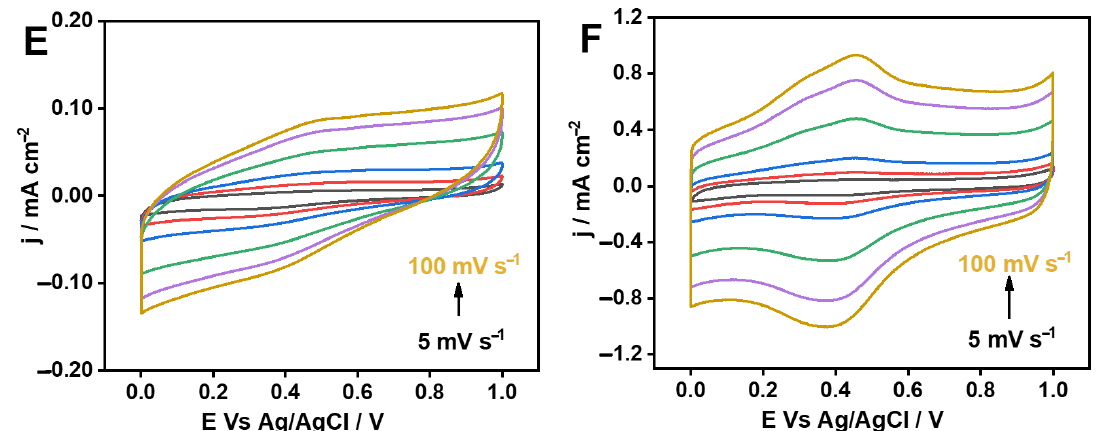
Figure 6. Scan rate effect studies in 0.5 M H 2 SO 4 of ( A ) graphite, ( B ) EPG, ( C ) EGO, ( D ) Electrochem- ical reduced EGO (rEGO), ( E ) CGO, and ( F ) Electrochemical reduced CGO (rCGO).